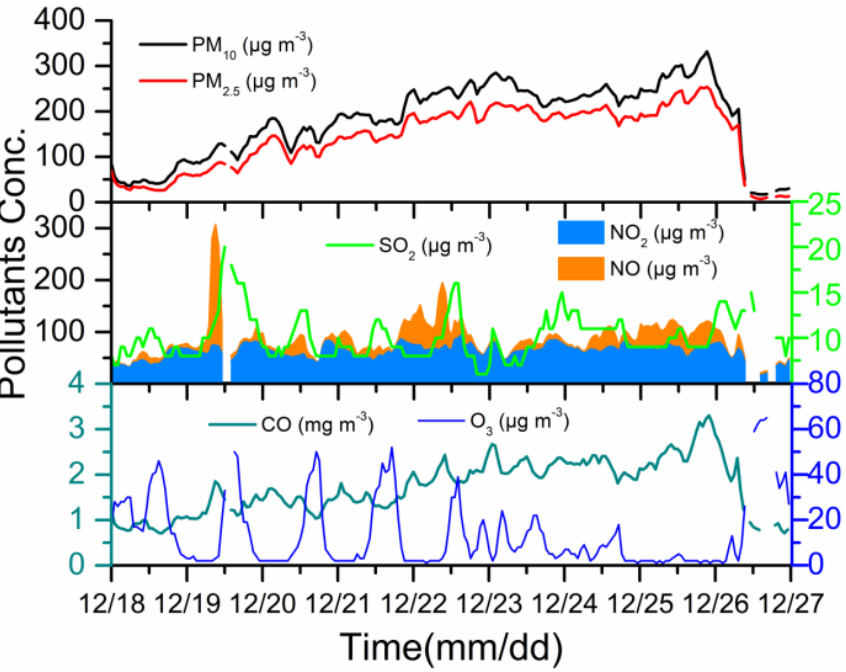
Figure 2. Meteorological conditions ( a , b ), concentration and chemical species of PM 2.5 ( c ), and contributions from each identified source of PM 2.5 ( d ) during 18 − 26 December 2019.